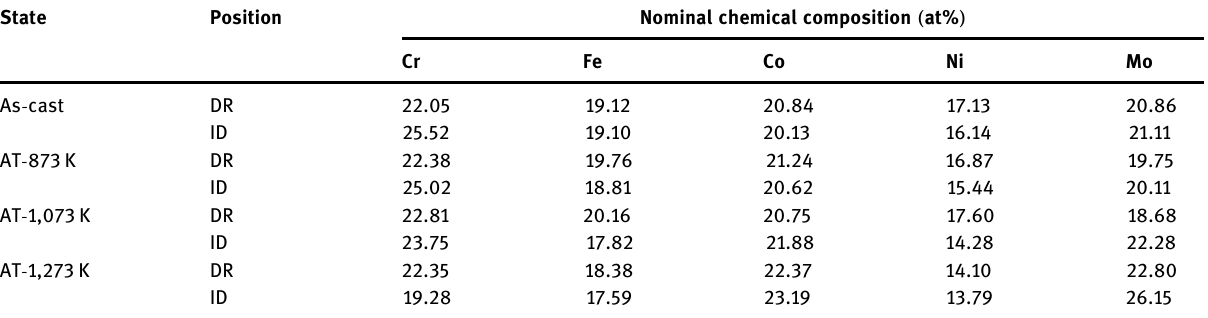
Table 2: Composition distribution of microscopic area in as - cast and annealed FeCoCrNiMo alloys State Position